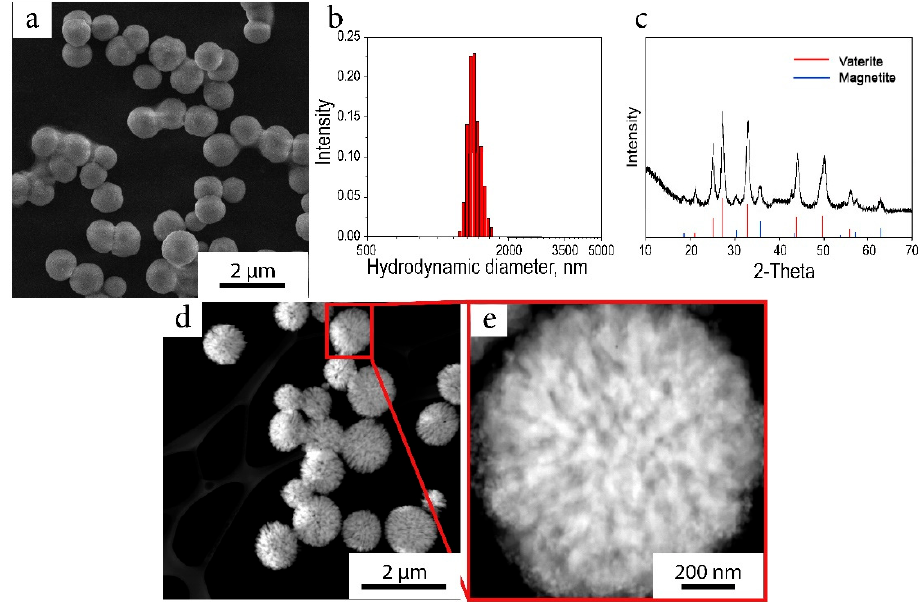
Figure 2. ( a ) SEM image of the magnetic composite particle; ( b ) the size distribution of hydrodynamic diameters in water solution; ( c ) XRD pattern of the composite particles; ( d ) STEM image of magnetic composite particles; ( e ) STEM image of the magnetic composite particles, in which the developed microstructure can be seen.